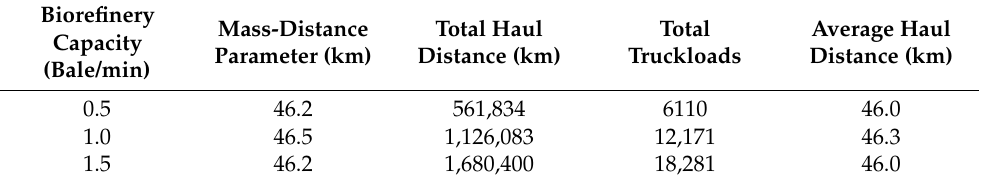
Table 3. Mass–distance parameters and haul distance results for all three biorefinery